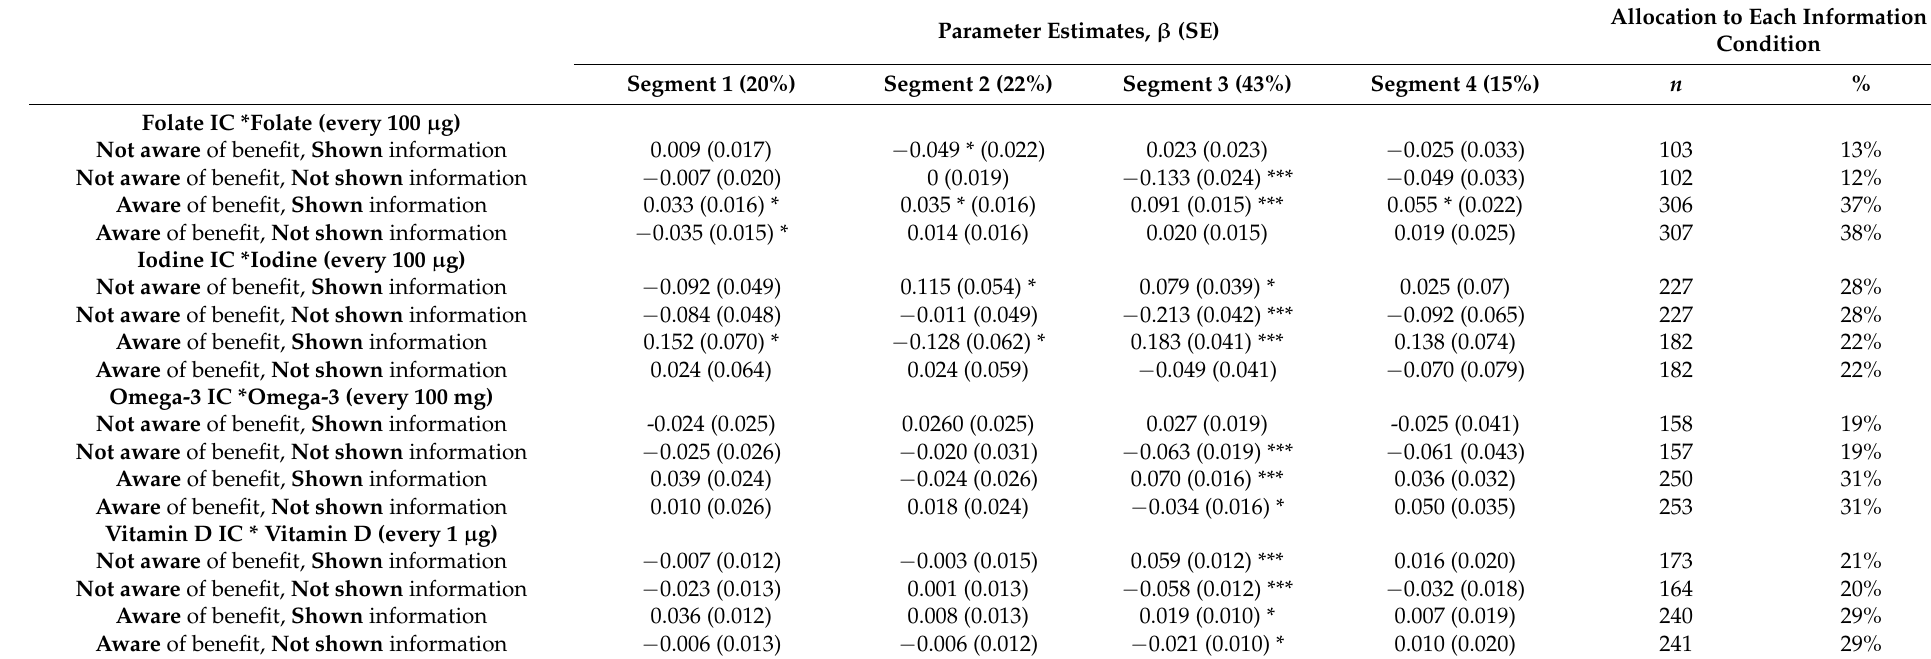
Table 2. Interaction effects showing the effect of information conditions (IC) on preferences for nutrient levels ( n =